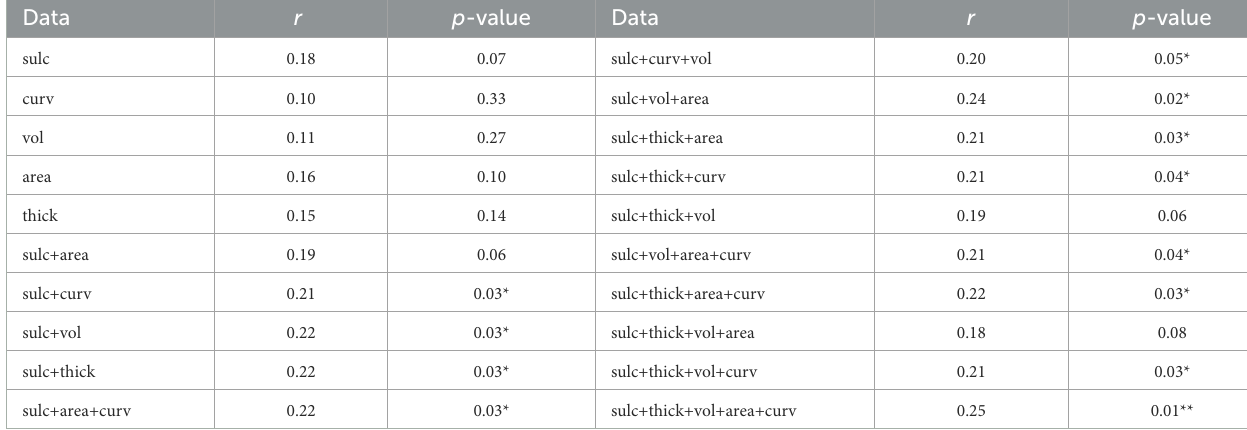
TABLE 4 The correlation analysis between 3-Hinges regions identification accuracy and the gender in